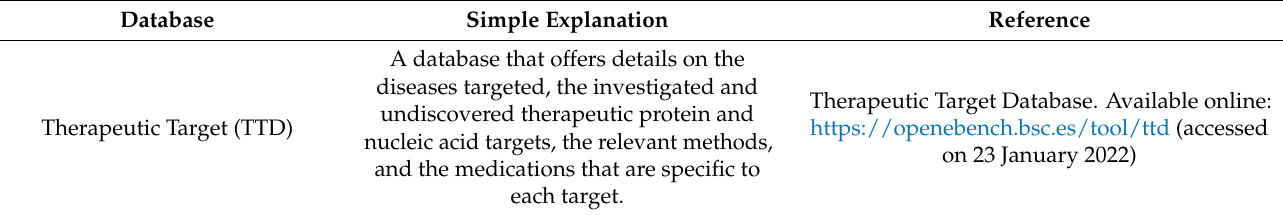
Table 2. Data sources for determining the correlations between drugs and